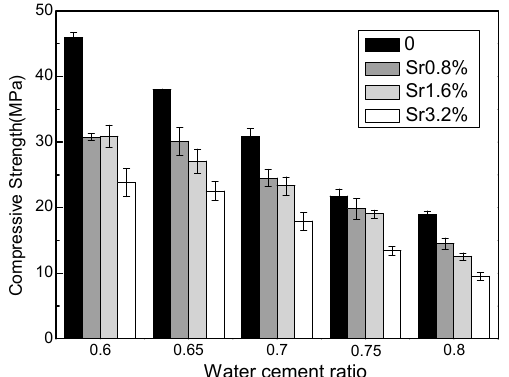
Figure 1. Influence of Sr content and water–cement ratio on 28-day compressive strength of the MgO–SiO 2 –H 2 O solidified bodies.